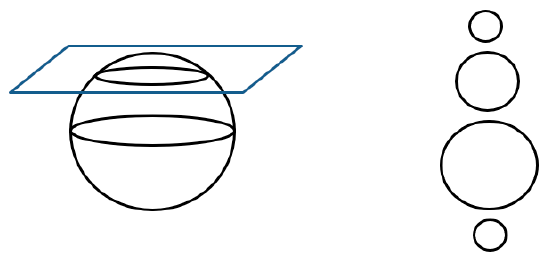
Figure 4. Qualitative change over time of the zone with the threshold concentration.